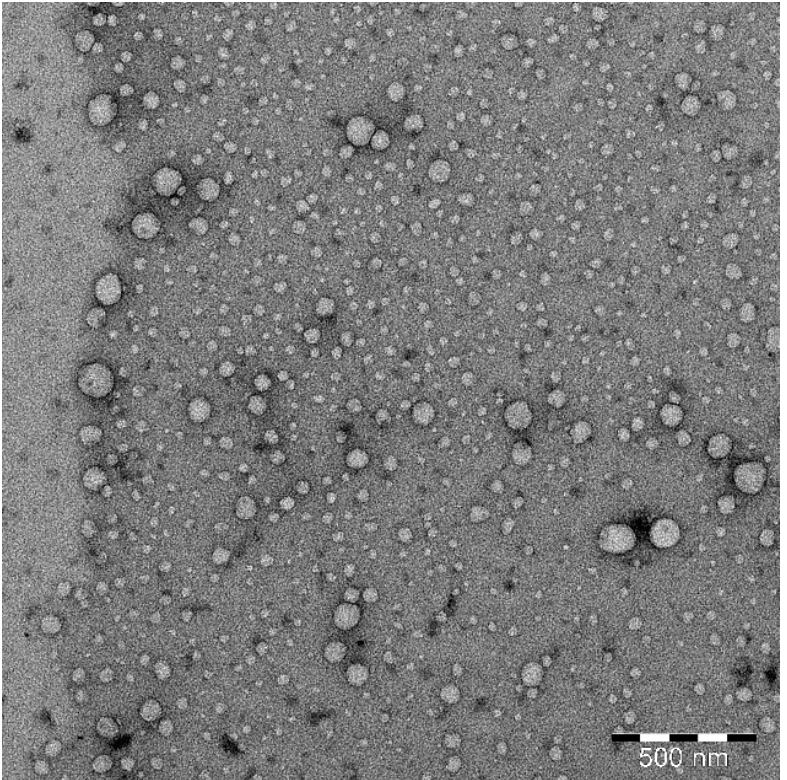
Figure 2. Transmission electron microscopy (TEM) image of optimized LUT-SNEDDS (LSN1) show- ing spherical-shaped droplets within nanometer range.